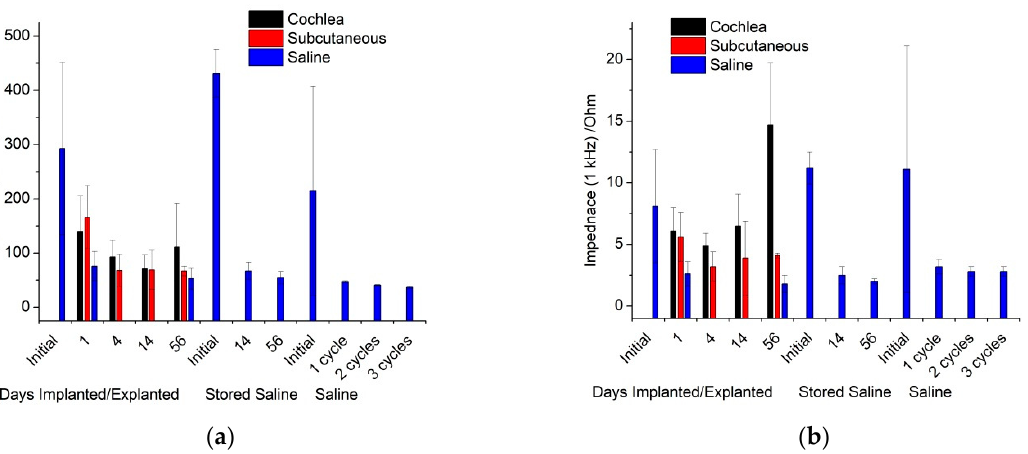
Figure 3. Impedance at ( a ) 15 Hz and ( b ) 1 kHz over time; initial, explanted, or stored electrode response in saline, or in vivo response in the cochlea or subcutaneously.